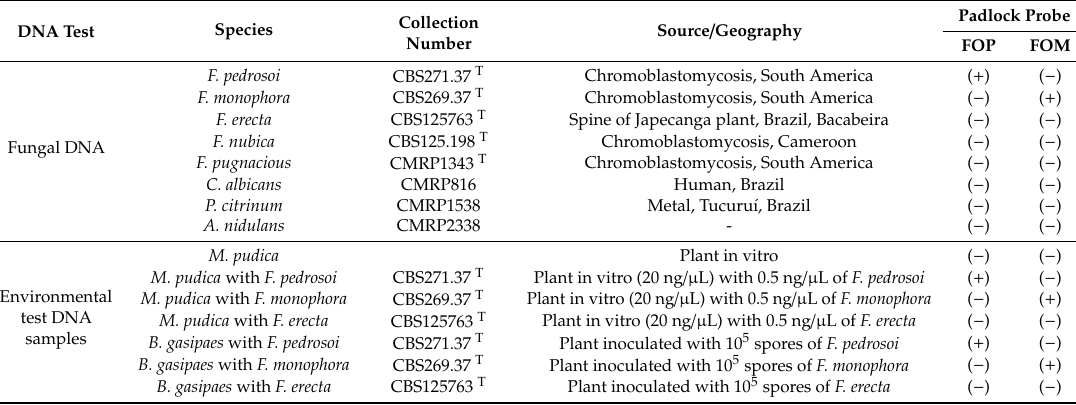
Table 1. In vitro specificity analyzes of the FOP and FOM probe